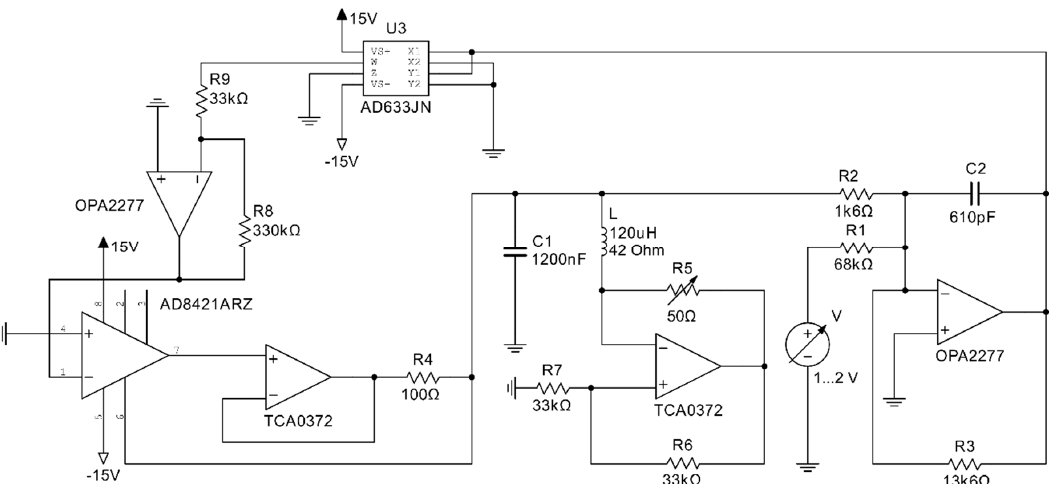
Figure 9. Voltage-controlled current sources (VCCS): ( a ) involving instrumental amplifier and operational amplifier; ( b ) involving two operational amplifiers.